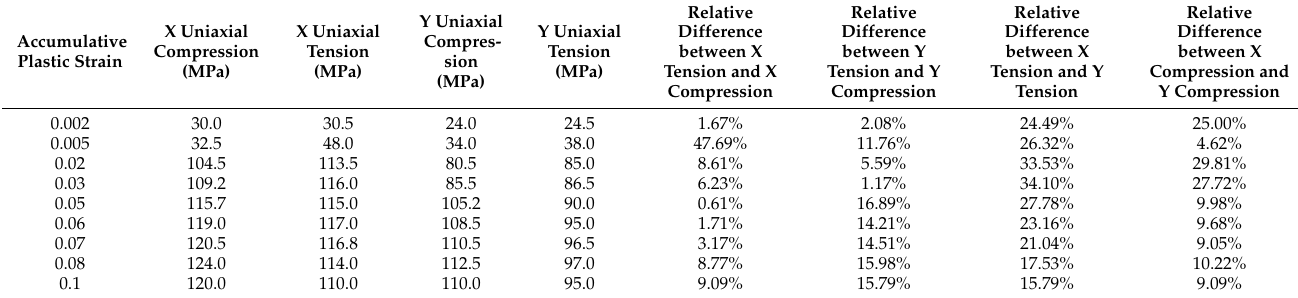
Table 4. Experimental yield values and relative